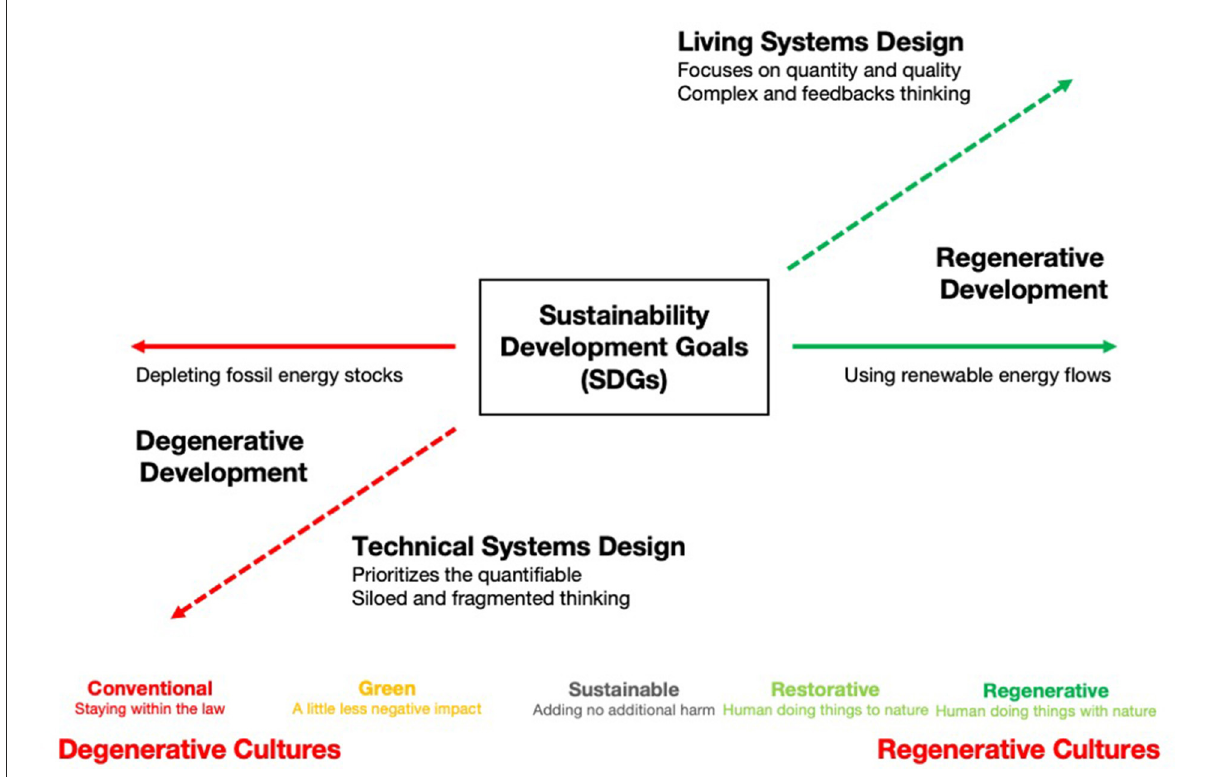
FIGURE1 From degenerative to regenerative cultures and ecologies (based upon (Wahl, 2016)).